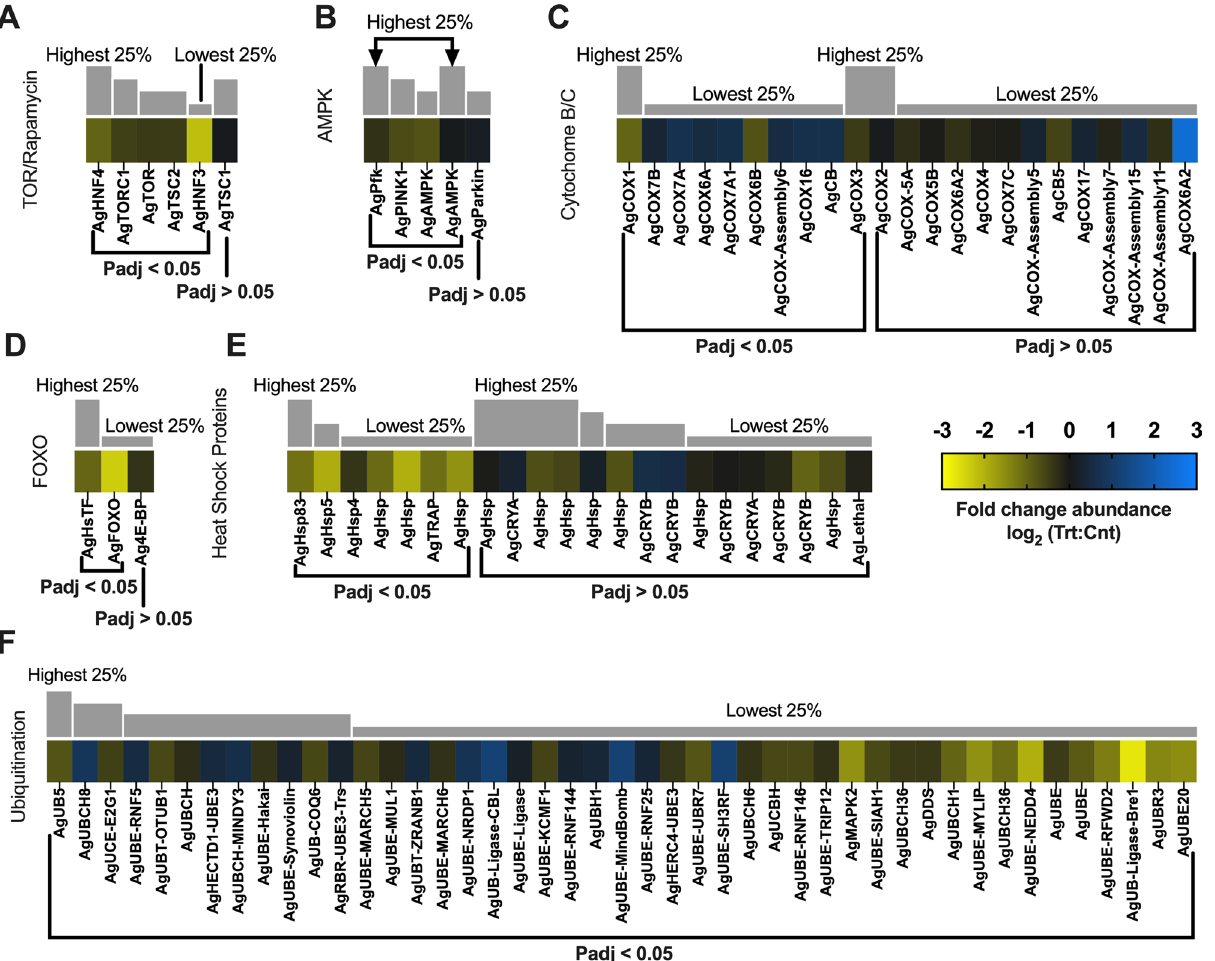
Figure 12. Aging biomarker differential transcript abundances following relevant sporozoite infections. Aging biomarker transcripts that were present at significantly higher (blue) or lower (yellow) levels in Plasmodium falciparum sporozoite infected treatments; non-differentially expressed Aging biomarker transcripts are denoted as zeros (black). Aging biomarker genes within each group organized by adjusted p-value and subsequently arrayed left to right from most abundant to least abundant based on FPKM values (quartile bars above each image). ( A ) TOR and rapamycin proteins. ( B ). AMPK proteins. ( C ) Cytochrome C and B proteins. ( D ) FOXO proteins. ( E ) Heat shock proteins. ( F ) Ubiquitination proteins. Log 2 scale indicates transcript abundances that were significantly higher (blue) or lower (yellow) in sporozoite infected treatments (Trt) vs. naïve controls